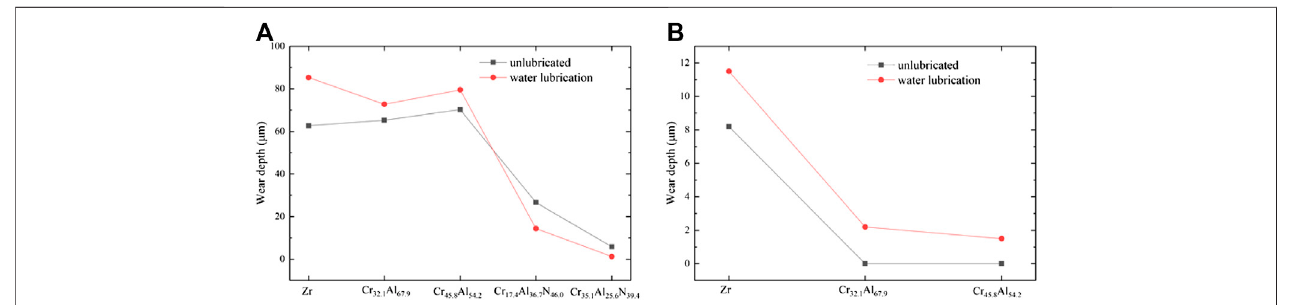
FIGURE 2 | Wear depth for various ATF candidates as a function of load and time under unlubricated and water lubrication condition: (A) 5 N, 10 min; (B) 1 N, 3 min.